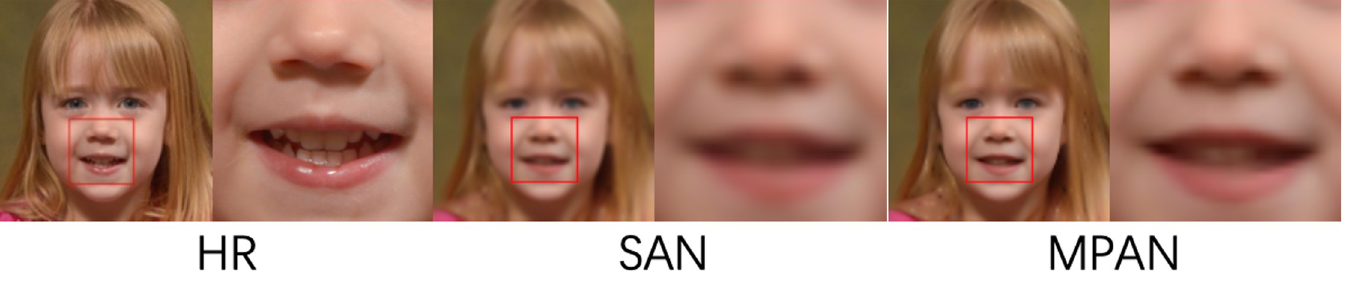
Fig 9. Comparative results of MPAN and SAN for 4X